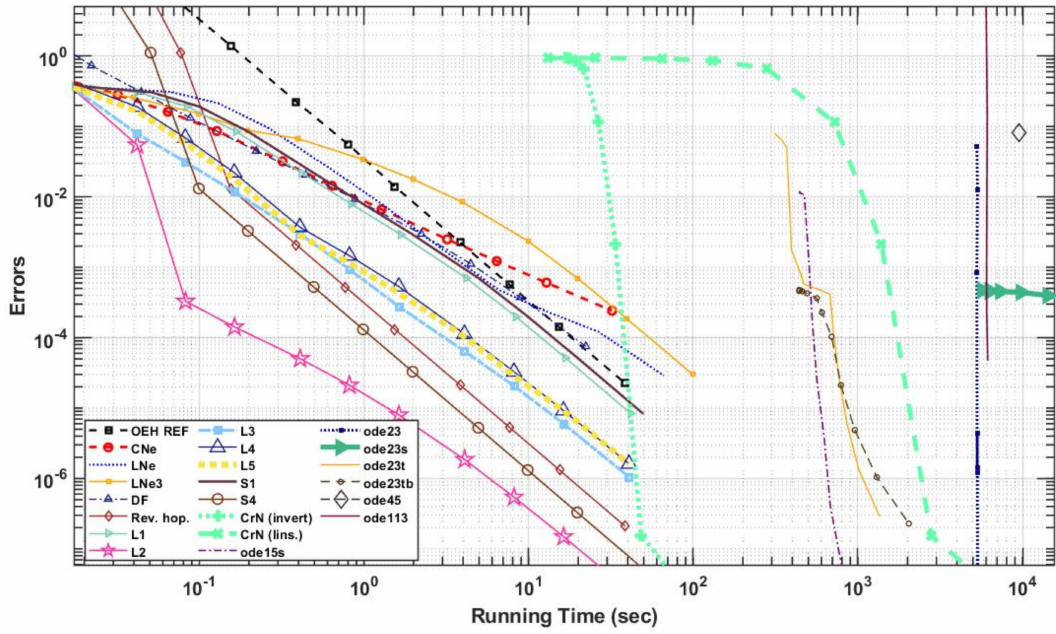
Figure 8. Errors as a function of the running time for the second (very stiff) system, in the case of the original OEH method (OEH REF), one stage CNe method, the new algorithms L1–L5, and several other